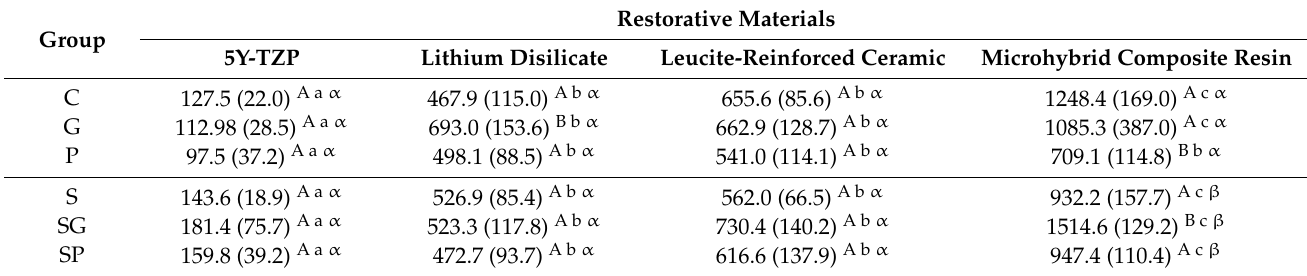
Table 3. The wear depth (WD) of dental restorative materials ( µ m), including stabilized zirconia with 5 mol% of yttrium oxide (5Y-TZP), lithium disilicate, leucite-reinforced ceramic, and microhybrid composite resin for all groups.